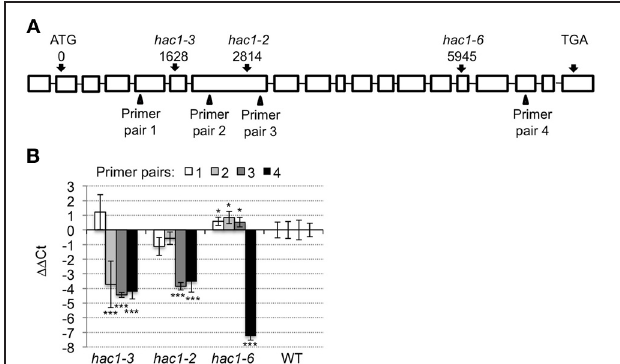
FIGURE 2 | HAC1 T-DNA locations and affects on HAC1 expression. (A) Boxes indicate exons and horizontal lines indicate introns in the HAC1 . The locations of the T-DNA inserts in the HAC1 genomic sequence (AT1G79000.2) are indicated with respect to the first nucleotide of the start codon. The positions of the four primer pairs used for the qRT-PCR analyses depicted in panel (B) are indicated by triangles. (B) Mutant and wild-type (WT) Arabidopsis seeds were surface sterilized and then incubated in the dark at 4 ◦ C for 3 days prior to being sown on nytex screens on Petri plates containing solid minimal Arabidopsis media. The seeds were incubated under continuous light at room temperature for 20h, and then the nytex screens and seeds were transferred to Petri plates containing Arabidopsis minimal media supplemented with 0.1M sorbitol. After an additional 12–13h, seeds were harvested, followed by isolation of RNA. Quantitative RT-PCR was then used to measure transcript levels. The transcript levels of ACT7 and UBQ6 were determined and the geometric means of their Ct used to normalize transcript levels. Transcript levels are expressed as (cid:2)(cid:2) Ct. − (cid:2) Ct (cid:2)(cid:2) Ct = (cid:2) Ct indicated pimer pair in wild - type indicated primer pair in indicated line . − Ct (cid:2) Ct = Ct indicated primer pair in indicated line ACT7 / UBQ6 in same line . Positive (cid:2)(cid:2) Ct values indicate that HAC1 transcript levels appear higher in the indicated hac1 line than in wild-type when measured using the indicated primer pair. Conversely, negative (cid:2)(cid:2) Ct values indicate that ACT7 transcript levels appear lower in the indicated hac1 line than in wild-type when measured using the indicated primer pair. Two technical replicates were performed for each biological replicate. Error bars indicate standard deviations. For each primer pair, the Student’s t -test was used to compare HAC1 transcript levels in each hac1 mutant line vs. wild-type. ∗ p < 0 . 1; or ∗∗∗ p < 0 . 02, according to a Student’s t -test. N = 4.